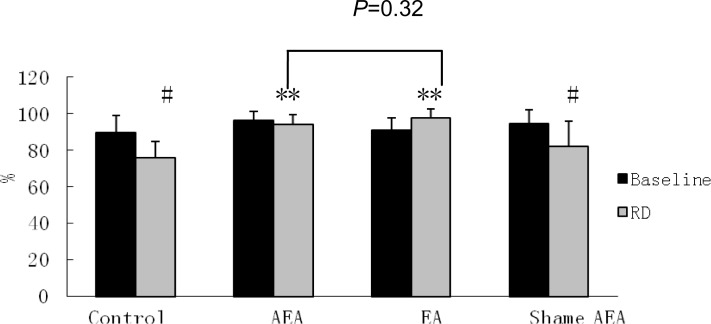
Effects of EA and AEA on RD-induced abnormal GSW.The percentage of GSW decreased significantly after RD in Control and Sham AEA group (#P<0.05 RD vs baseline). While the abnormal GSW induced by RD were repaired significantly after using EA or AEA with RD (**P<0.05 RD plus EA/AEA vs RD). The effect between EA and AEA on repairing the impaired GSW induced by RD was no significant difference (P = 0.32).